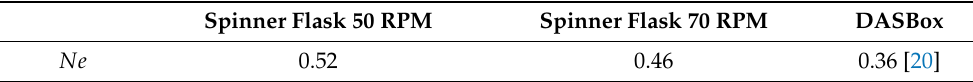
Table 1. Newton numbers for the Bellco spinner flask and the DASBox